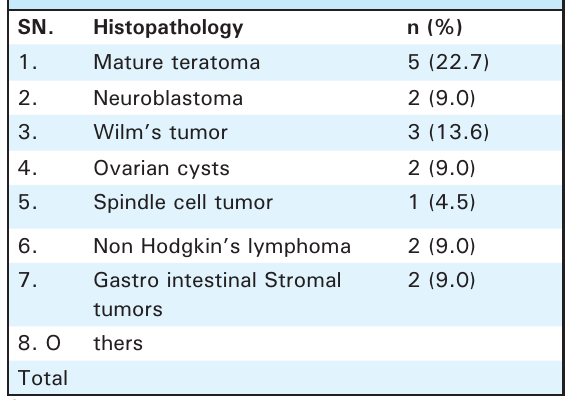
Table 3. (cid:2)(cid:3)(cid:4)(cid:5)(cid:6)(cid:7)(cid:8)(cid:5)(cid:9)(cid:6)(cid:10)(cid:6)(cid:11)(cid:3)(cid:12)(cid:8)(cid:10)(cid:13)(cid:14)(cid:15)(cid:16)(cid:3)(cid:15)(cid:11)(cid:4)(cid:17)